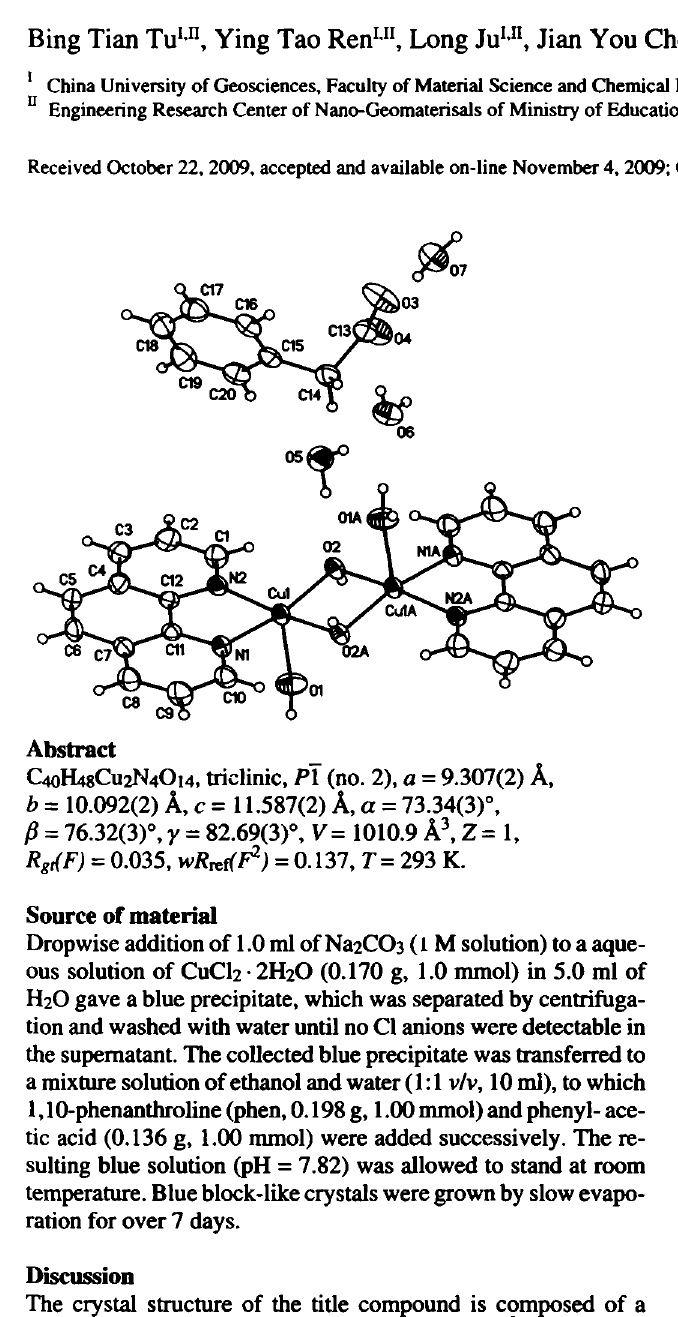
Table 2. Atomic coordinates and displacement parameters (in Â 2